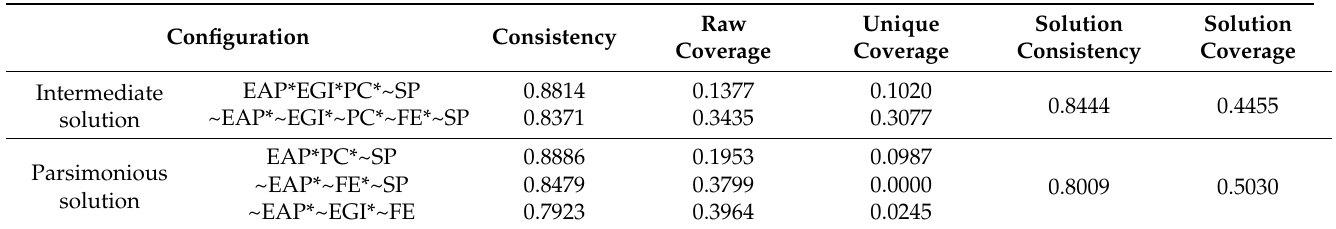
Table A2. The analysis of intermediate solutions and parsimonious solutions for low